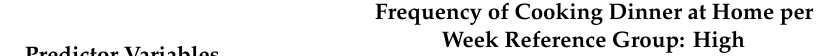
Table 2. Multinomial logistic regression model showing OR (odds ratio) for cooking frequency groups among Non-Hispanic Black adults (age ≥ 19 years): NHANES, 2007–2010. (observations = 2336; weighted population